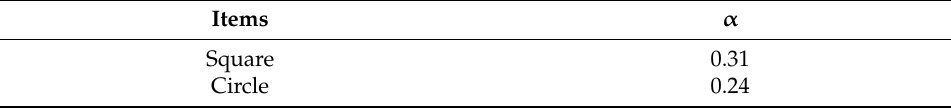
Table 1. Shape parameters of pressure-sensitive diaphragm [35]. Items Square